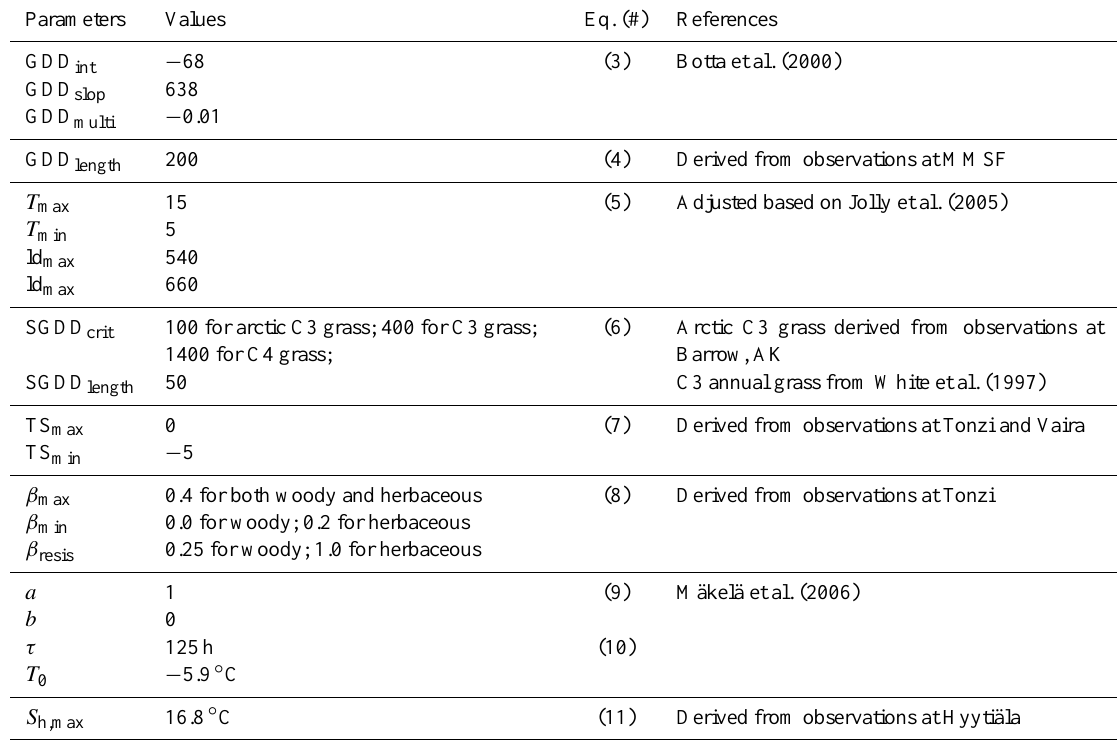
Table 2. Parameters in phenology